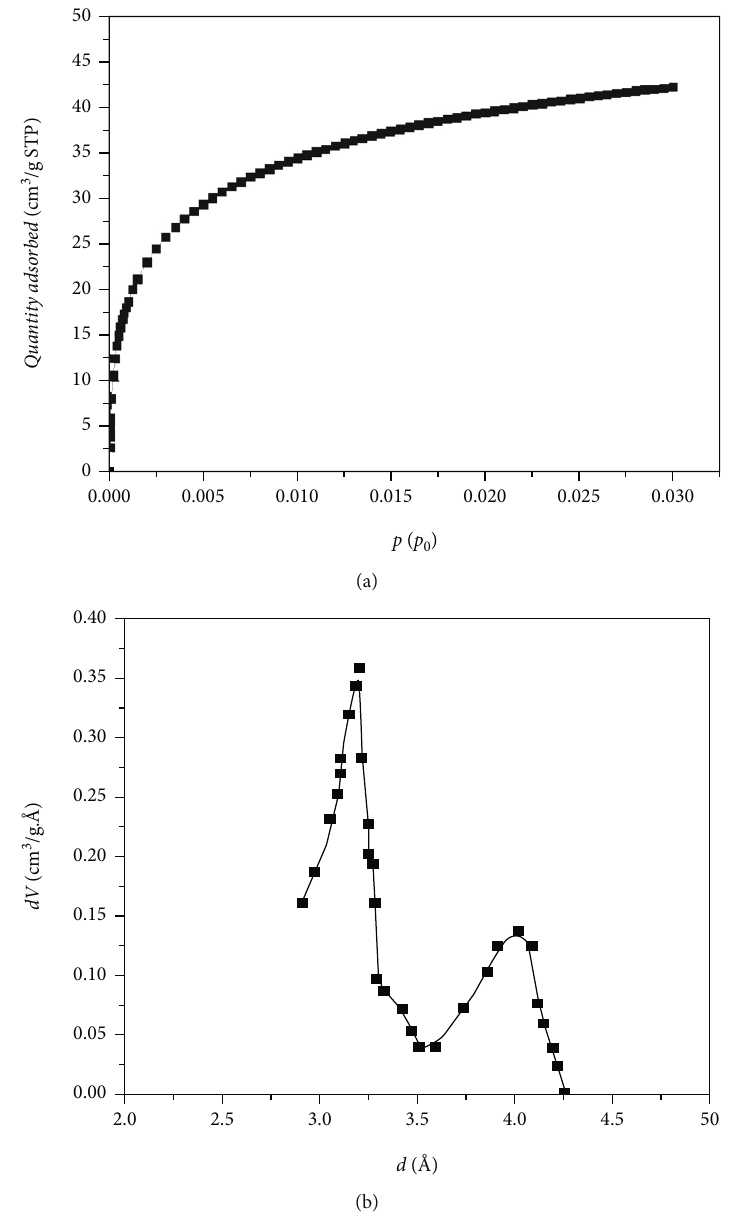
Figure 5: (a) Low-temperature CO